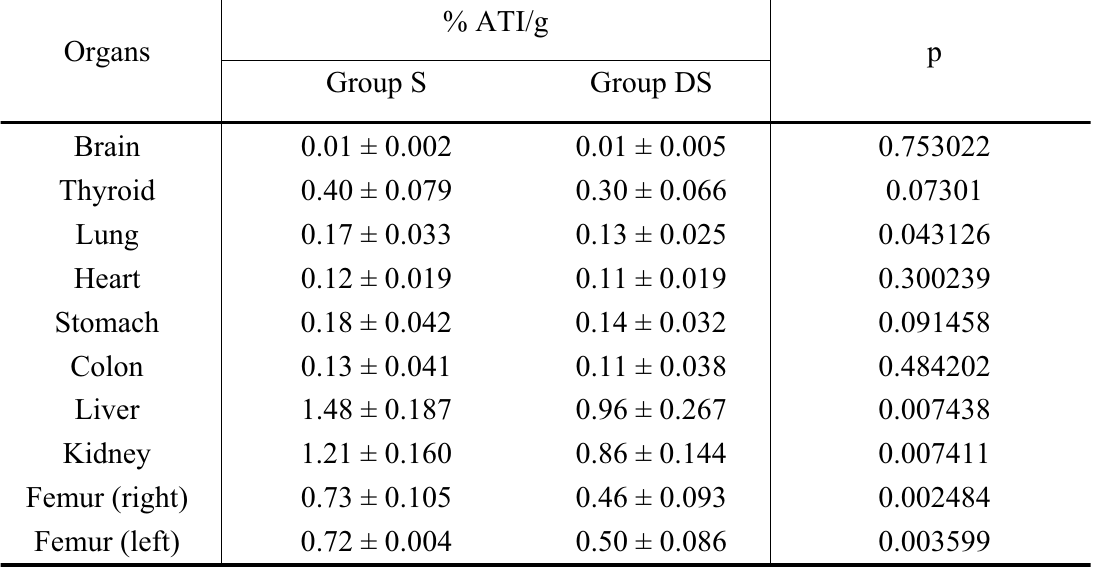
TABLE 1 - Comparison of percentage of radioactivity/g (% ATI/g) of samples from each organ of rats treated with Sm- 153-EDTMP (group S) and with docetaxel + Sm-153-EDTMP (group DS)